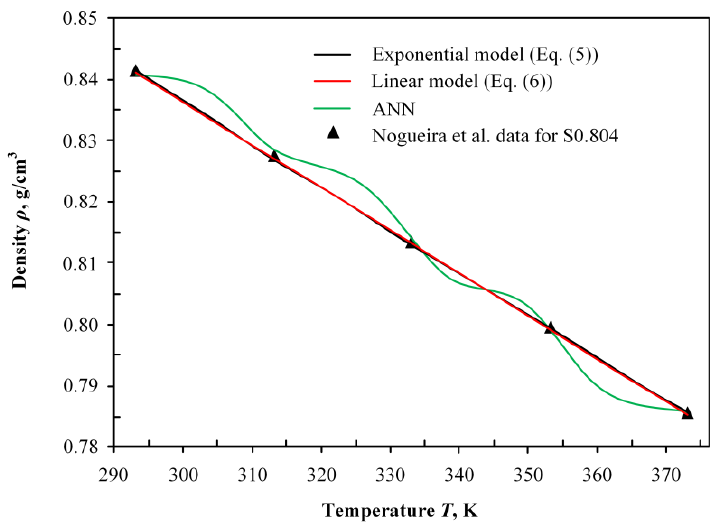
Fig. 6. Variation in density of S0.804 vs.